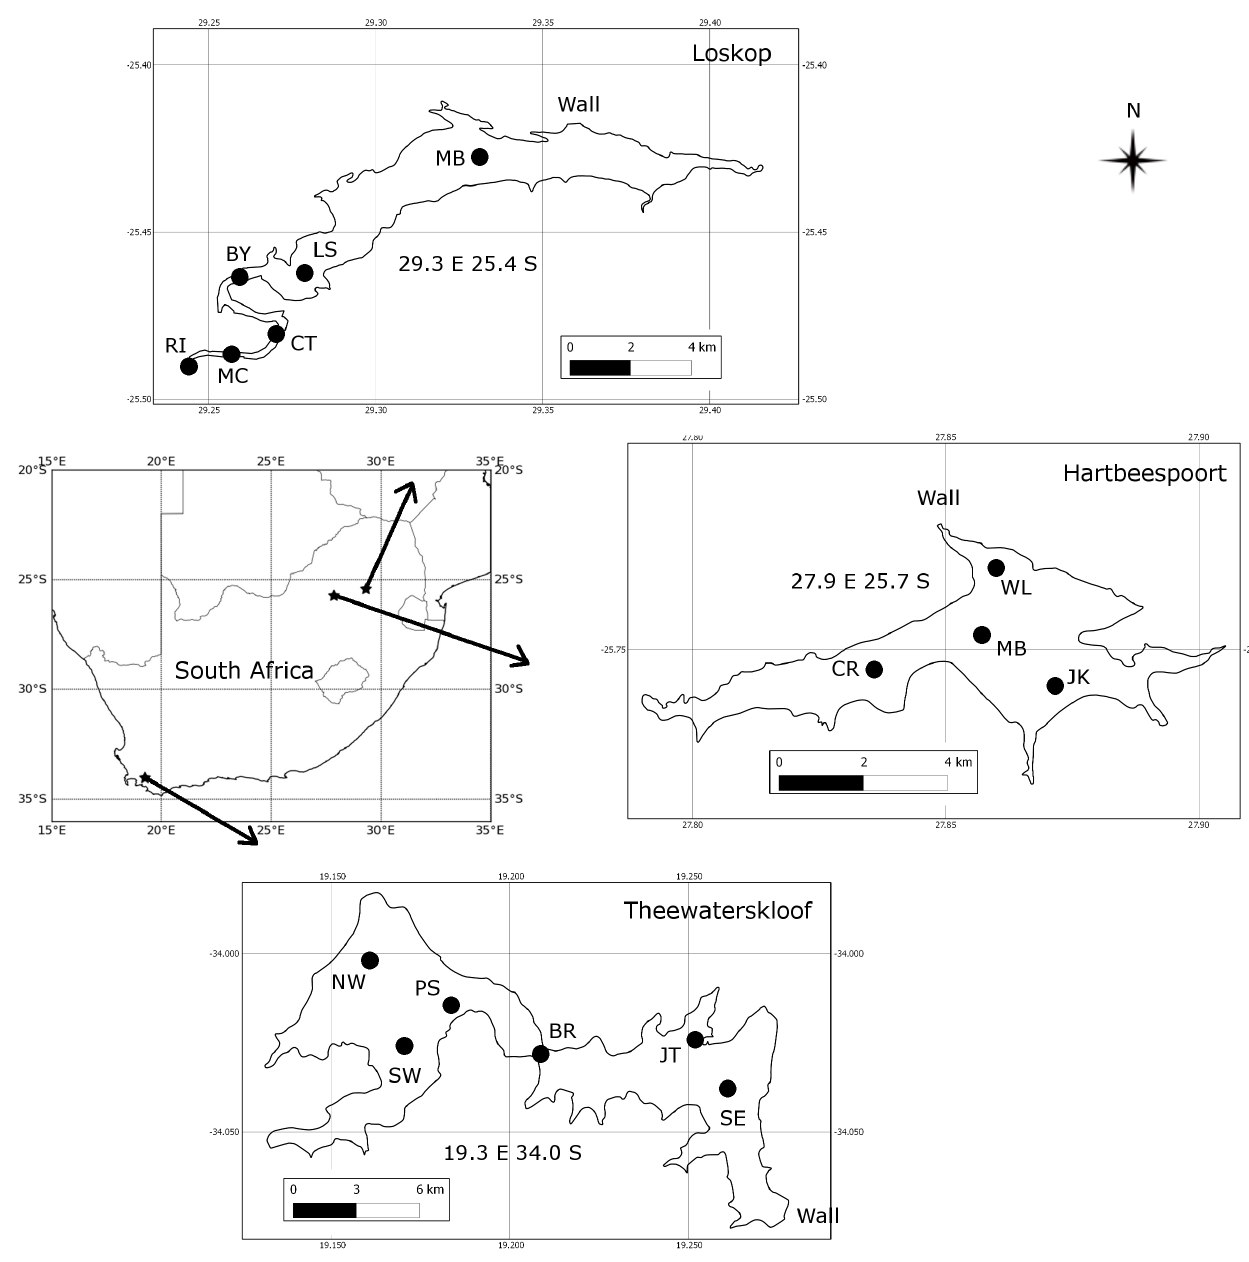
The geographical location and shapes of the three reservoirs, Loskop, Hartbeespoort and Theewaterskloof. Sample points are indicated with labeled dots (see text for